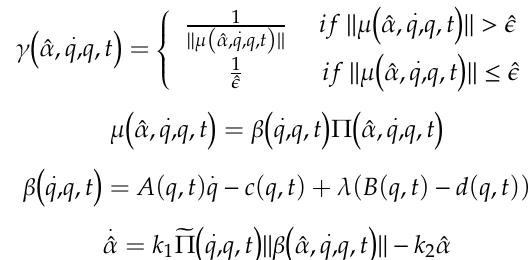
Figure 13. Control structure diagram of the rope traction part of the system.